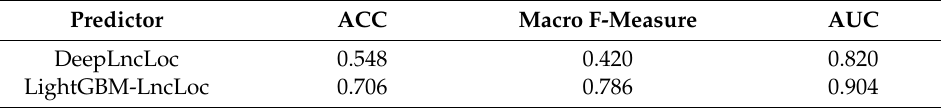
Table 6. Performance on 5-fold cross-validation.